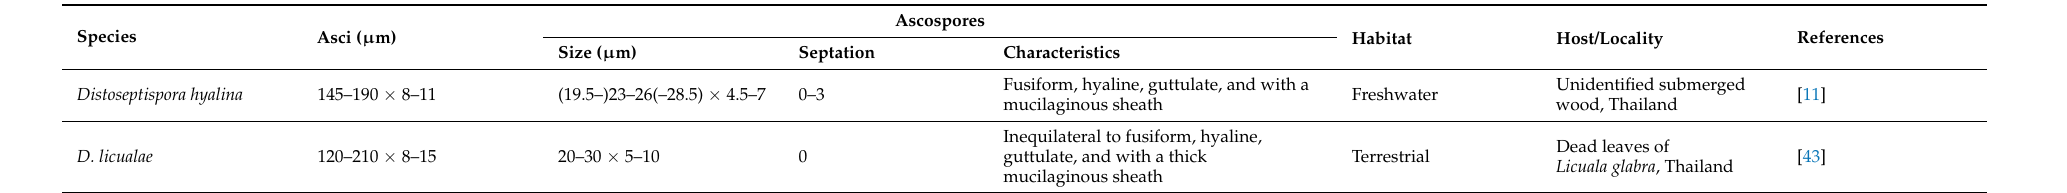
Table 3. Synopsis of morphological characteristics, habitat, host, and locality compared across Distoseptispora teleomorph